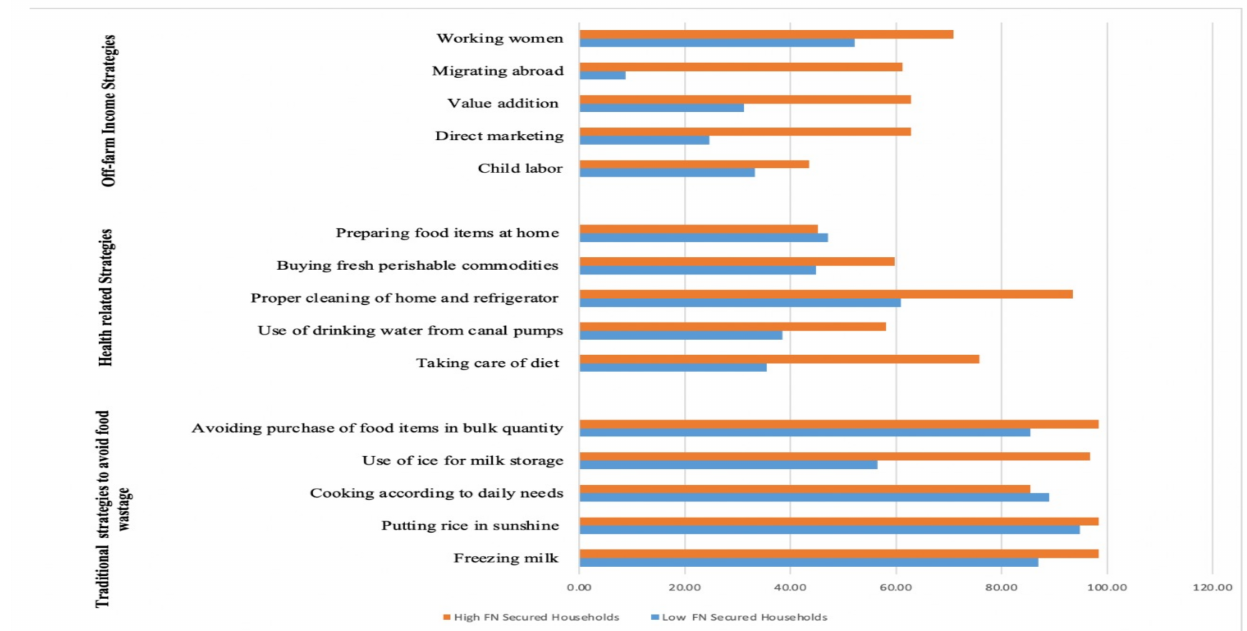
Figure 3. Prevalence of off-farm strategies among high and low FNS